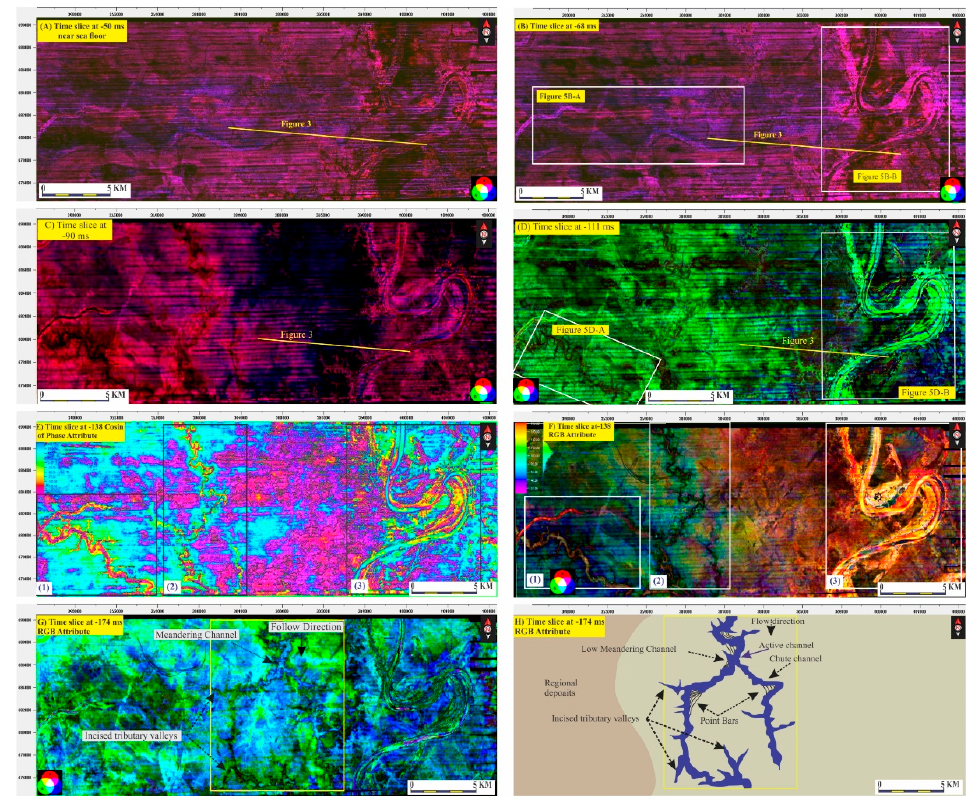
Figure 5. ( A – H ) Reveals the Melor and Inas fields’ time slices at particular two-way times and covering an area of approximately 574 km 2 . ( A ) Time slice of spectral decomposition attribute at − 50 ms below the seafloor, ( B ) the time slice at − 68 ms below the seafloor. ( C ) Time slice at − 90 ms and the top major sinuous channel’s uppermost features extending throughout the widespread channel belt in the right-side of the map-view with the other two minor channels in the left and south of the map-view. ( D ) The time slice at − 111 ms exhibiting the major sinuous channel in the right side of the map view (Figure 5(D-B) and a minor meandered channel with its tributaries in the southwest of the map view (Figure 5(D-A). However, ( E ) shows time slice of the seismic Cosine of Phase attribute, revealing the time succession’s fluvial channels system. ( F ) represent RGB color blending at − 138 ms, exposing a continental meandering fluvial channel with paleo-flow trajectory from north to south. A minor sinuous channel is shown in the middle of the map-view. A medium sinuous channel is displayed with several tributaries at the southwest of the map view. ( G ) The time slice of the RGB color blending at − 174 ms, displaying a continental low sinuous channel in the middle of the map-view with paleo-flow trajectory from north to south. ( H ) Explanation diagram highlighting the targeted channel with its tributaries and paleo-flow trajectory.